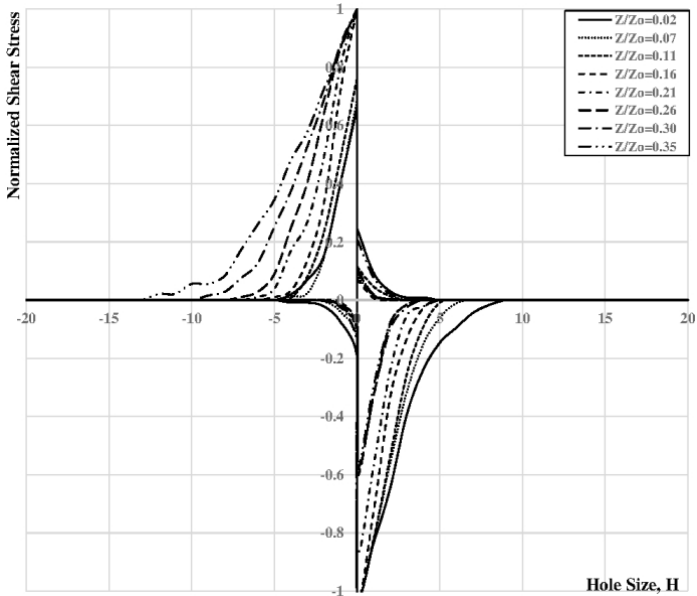
Figure 8. Quadrant analysis of the bursting events close to the weir (x = 2.55 m from origin of the flume).